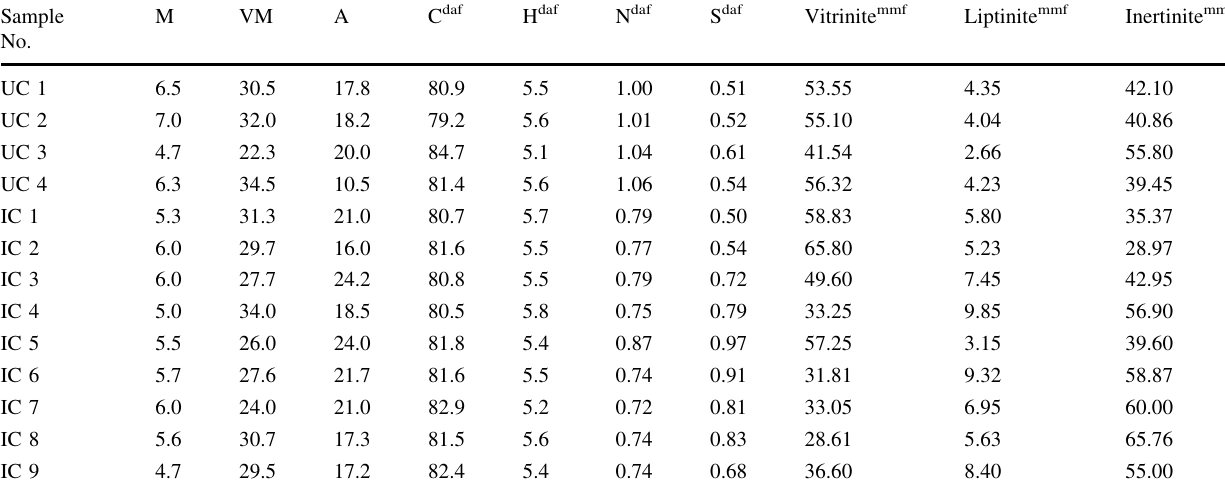
Table 1 Chemical and petrographic characteristics of Umaria and IB-valley coal Sample No.